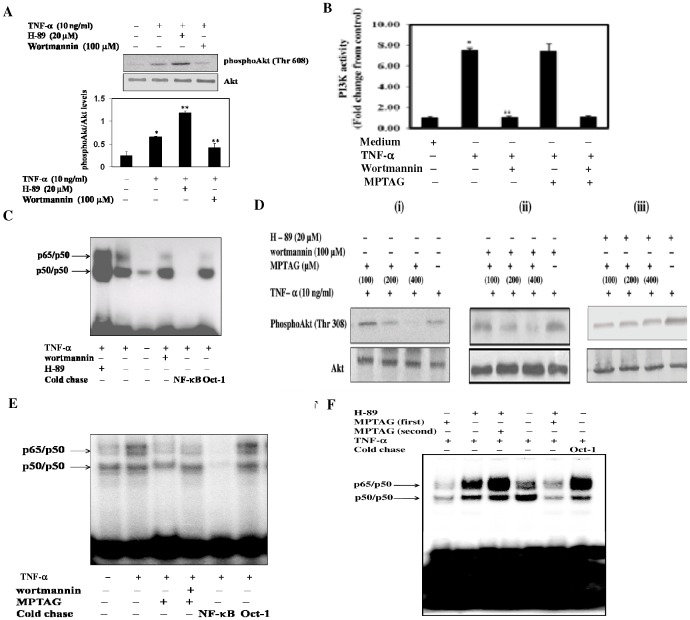
MPTAG blocks Akt activation and NF-κB activation in a PI-3K independent and PKA-dependent manner in TNF-α-stimulated HUVECs.(A) The cells were either preincubated with wortmannin (100 µM) or H-89 (20 µM) for 30 mins and then induced with TNF-α (10 ng/ml) for additional 30 mins. The total cell extracts were subjected to western blot analysis using anti-phospho-Akt (Thr308) and anti-Akt antibodies. (A; lower panel) The intensity of bands were densitometrically scanned and normalized with Akt levels. The values presented are mean ± SEM. *p<0.02 vs. uninduced cells; **p<0.05 vs. TNFα-induced cells, statistical difference was set at p<0.05. (B) The cells were pretreated with wortmannin in absence and presence of MPTAG before induction with TNF-α. The total cell extracts were subjected to PI3K assay (see “Methods”). The mean value (in pmol) for cells treated with neither MPTAG nor TNF-α (control) was set to 1, and -fold changes were determined by comparing values against this set value. The values presented are mean ± SEM. *p<0.002 vs. uninduced cells; **p<0.005 vs. TNF-α-induced cells, statistical significance was set at p<0.05. (C) The cells were treated and induced as described in (A). The nuclear extracts were assessed for NF-κB activation by EMSA. Effect of MPTAG on Akt phosphorylation in absence and presence of wortmannin and H-89 in TNF-α-stimulated HUVECs. (D; panels (i–iii)). For this, the cells were incubated without or with either wortmannin or H-89 before treatment with different concentrations of MPTAG followed by induction with TNF-α. The total cell extracts were subjected to western blot analysis using anti-phospho-Akt (Thr308) and anti-Akt antibodies. Effect of MPTAG on NF-κB activation in absence and presence of wortmannin and H-89 in TNFα-stimulated HUVECs. (E–F) The cells were treated and induced as stated in (D). The nuclear extracts were prepared and assessed for NF-κB activation by EMSA.